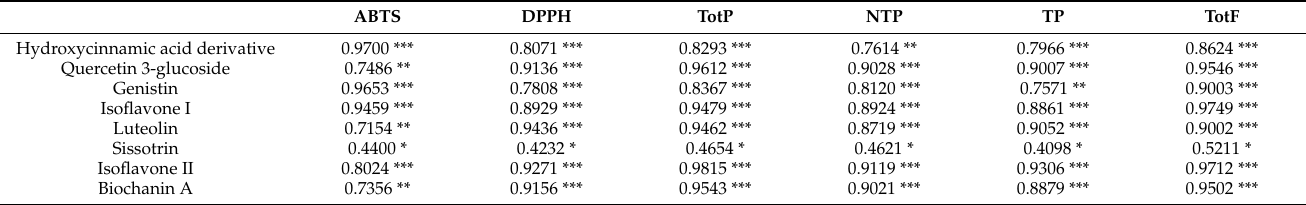
Table 8. Correlations ( R 2 ) established between antioxidant capacity (ABTS, DPPH), total phenolics (TotP), non-tannic phenolics (NTP), tannic phenolics (TP), total flavonoids (TotF), and individual phenolic compounds in Trifolium subterraneum shoots.